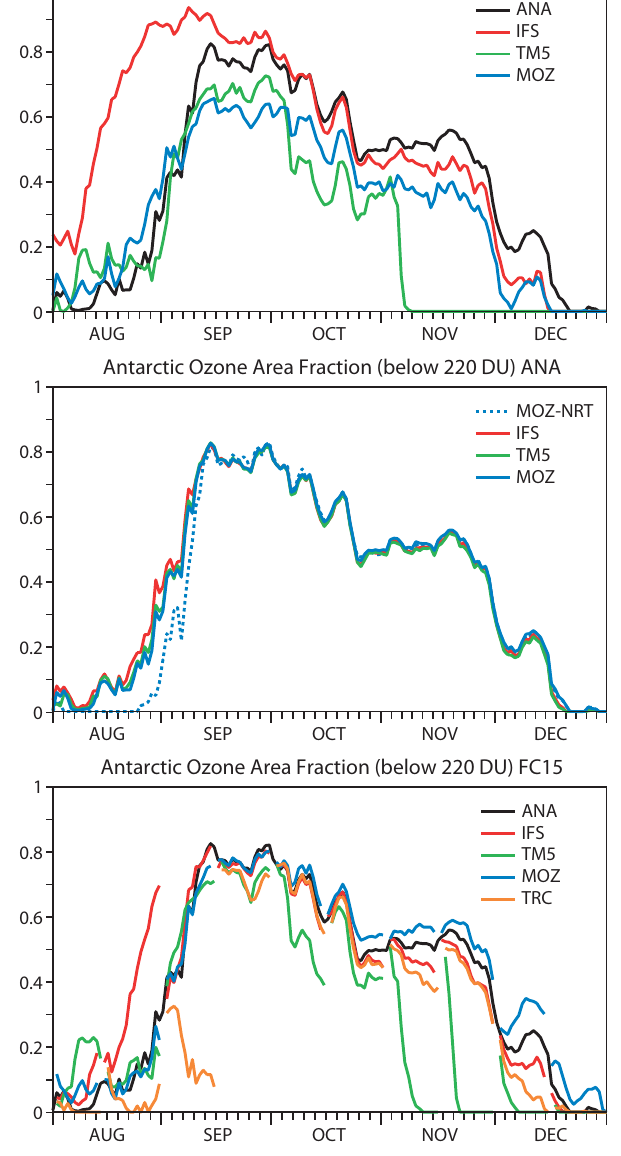
Fig. 7. Area fraction below 220DU in the area 62 ◦ S–90 ◦ S at 12:00UTC from the runs without assimilation (FC, top), runs with assimilation (ANA, middle) and the runs initialized only on the 1st and 16th day of each month (FC15, bottom) by IFS-MOZART (MOZ, blue), IFS (red), IFS-TM5 (green) and a tracer without chemistry (TRC, orange, FC15 only). See Table 1 for the assim- ilated satellite observations. MLS was not assimilated in the NRT ANA ∗ run with IFS-MOZART (MOZ-NRT, dotted blue line, mid- dle panel only).